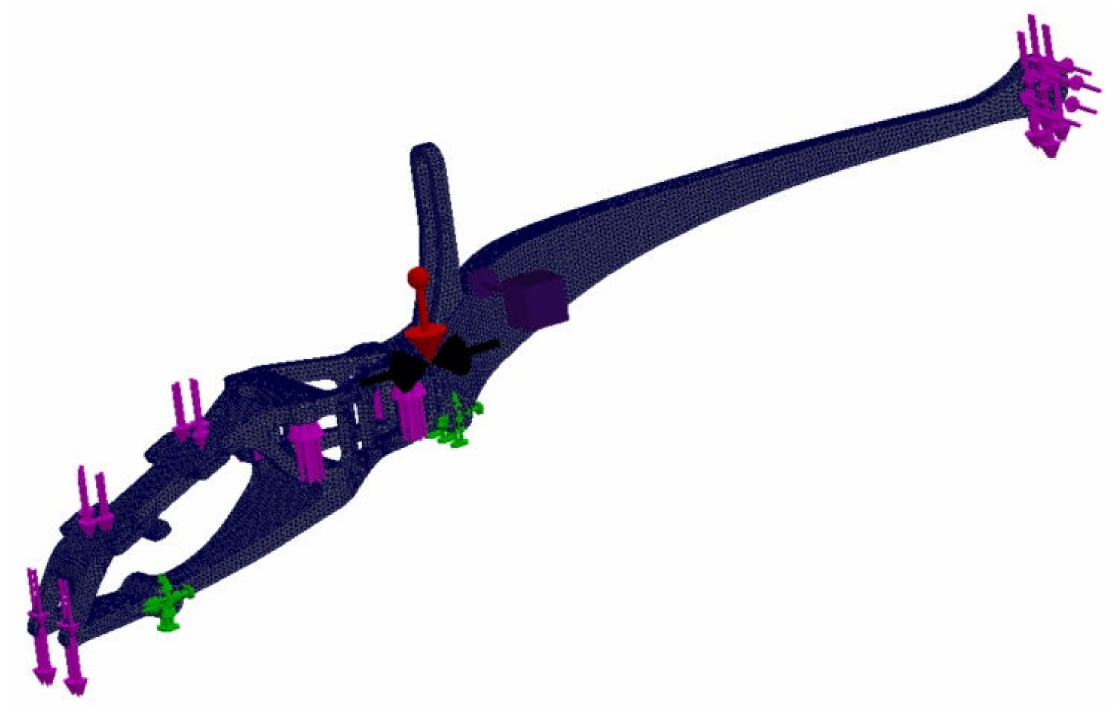
Figure 16. Boundary conditions and loads in frame geometry used in topology analysis, model divided into finite